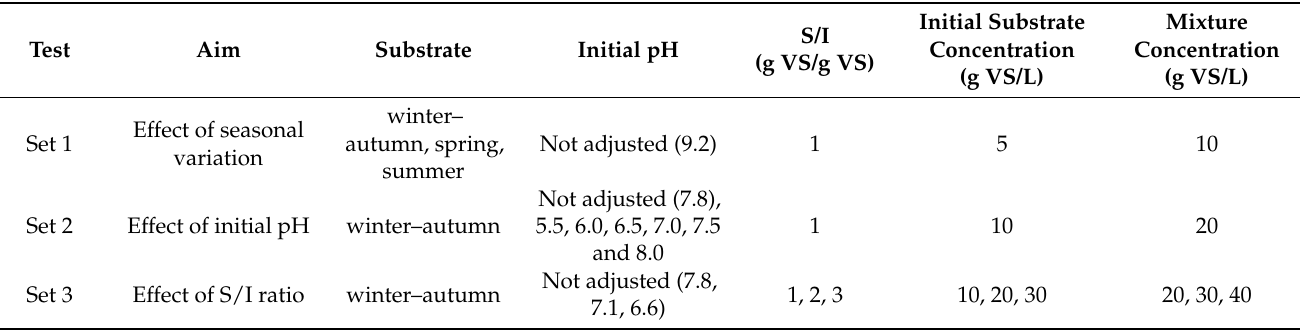
Table 2. Experimental conditions in terms of substrate season, initial pH, and substrate/inoculum (S/I) ratio used in the biochemical hydrogen potential